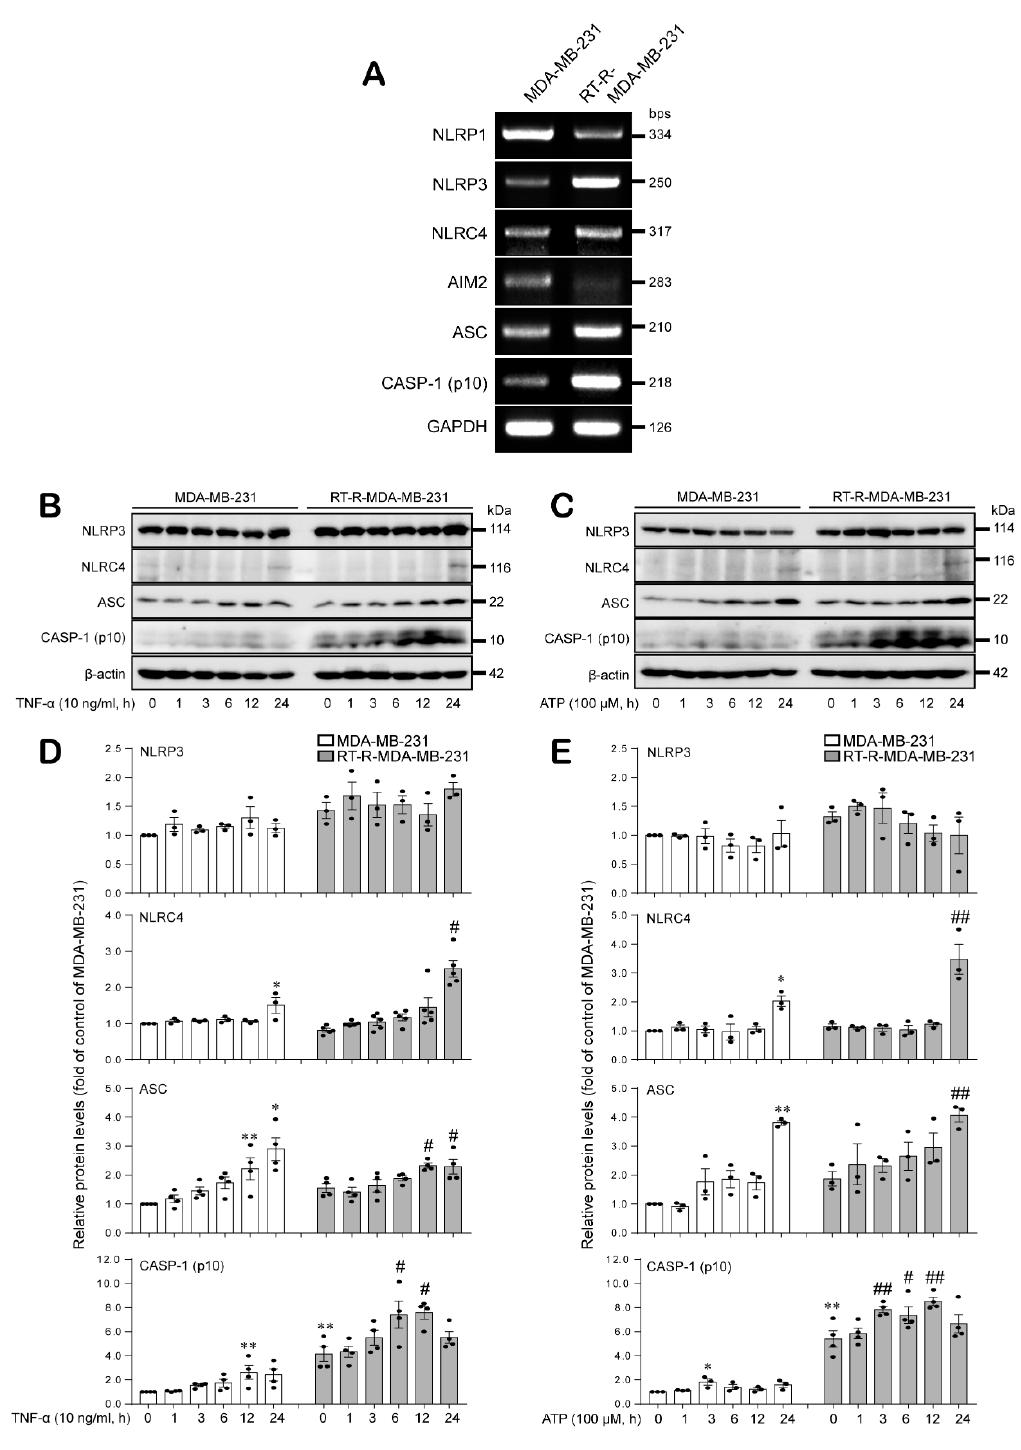
Figure 1. Expression level of inflammasome components and induction of these components in response to tumor necrosis factor- α ( TNF- α) and ATP in both MDA-MB-231 and radiotherapy-resistant (RT-R)-MDA-MB-231 cells. ( A ) Total RNA was collected, and the mRNA levels of inflammasome components (nucleotide-binding domain-like receptor NOD-, LRR-, and pyrin domain-containing protein 1 (NLRP1); NLRP3; NLRP6; nucleotide-binding domain-like receptor (NLR) family CARD domain containing 4 (NLRC4); absent in melanoma 2-like (AIM2); apoptosis-associated speck-like protein containing a CARD complex (ASC); and cleaved caspase-1) and glyceraldehyde 3-phosphate dehydrogenase (GAPDH) were analyzed by RT-PCR as described in the Methods section. ( B-E ) MDA-MB-231 and RT-R-MDA-MB-231 cells were treated with TNF- α (10 ng/mL) ( B, D ) or ATP (100 μM) ( C, E ) for the indicated times. Then, NLRP3, NLRC4, ASC, cleaved caspase-1 (p10), and β -actin protein levels were analyzed by Western blotting ( B, C ). The band